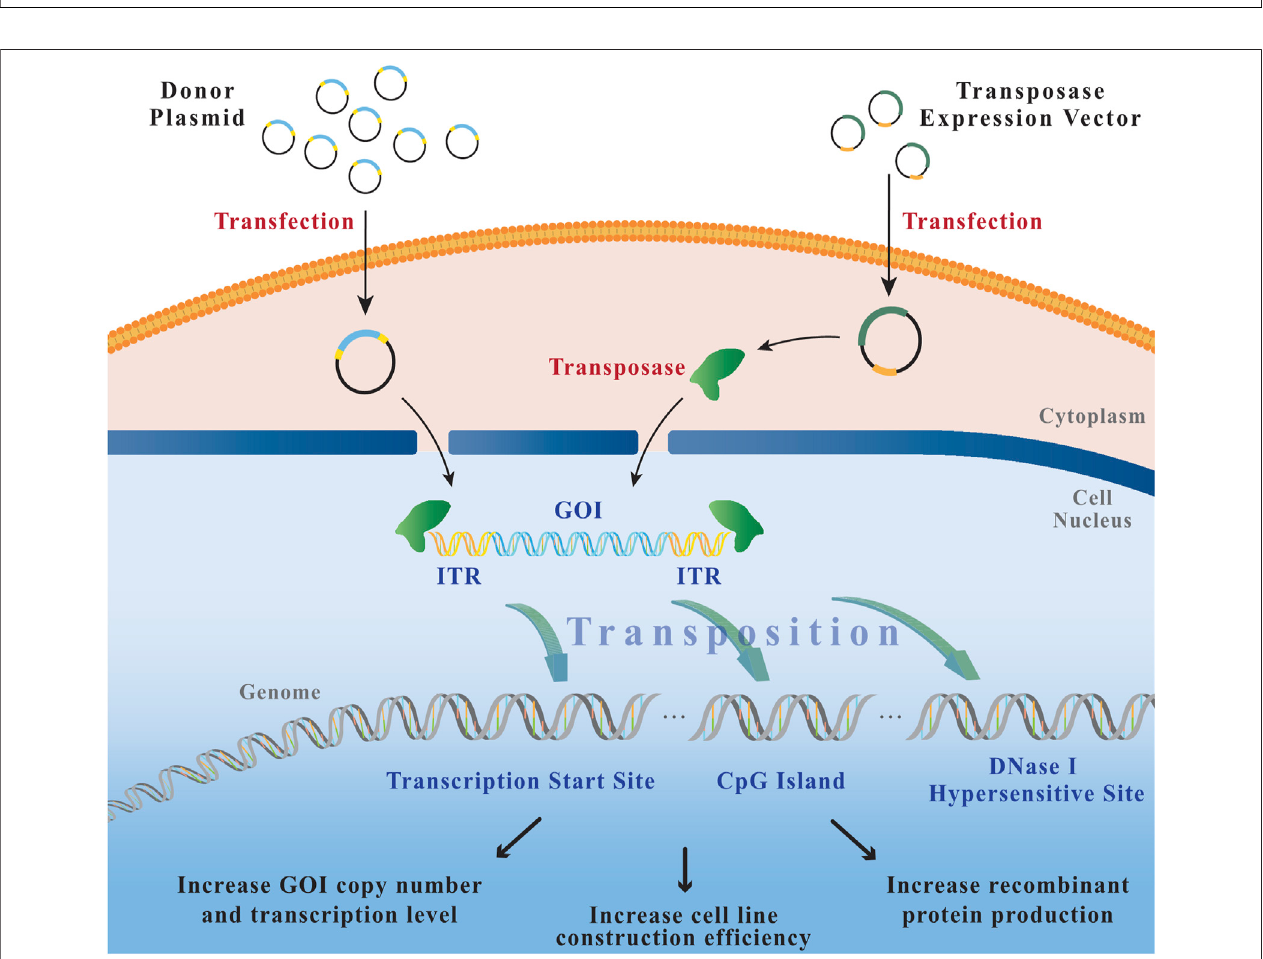
FIGURE 2 | The process of transposition. After co-transfection of the donor plasmid (transposon) and the helper plasmid (transposase), the transposase binds to the ITRs of the donor plasmid, cuts the transposon vector fragment from the plasmid backbone, and integrates it into the host cell genome through a “ cut-and-paste ” mechanism. GOI: gene of interest; ITR: inverted terminal